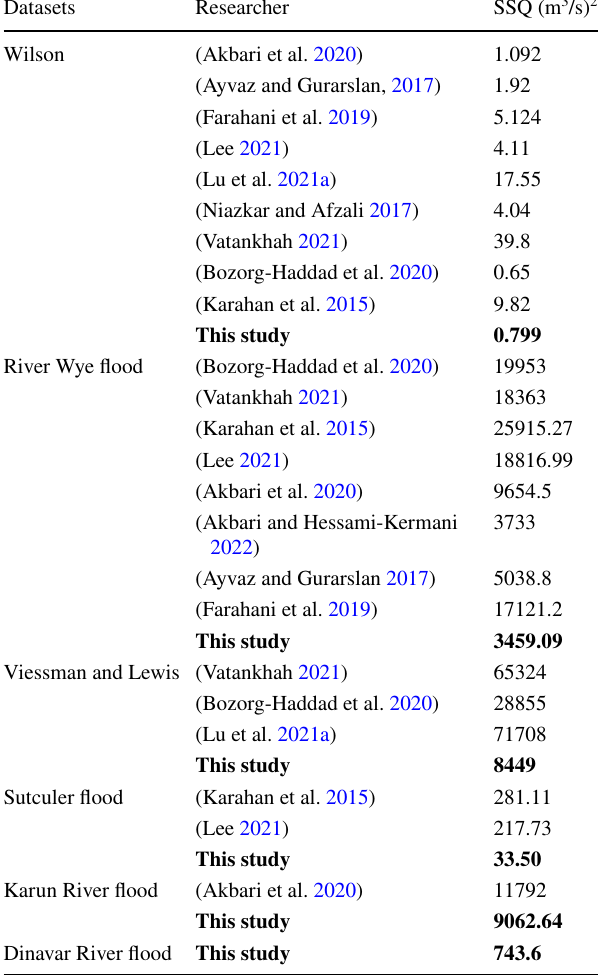
Table 9 Comparison of the NL5-AL results with previous studies for examples 1 to 6